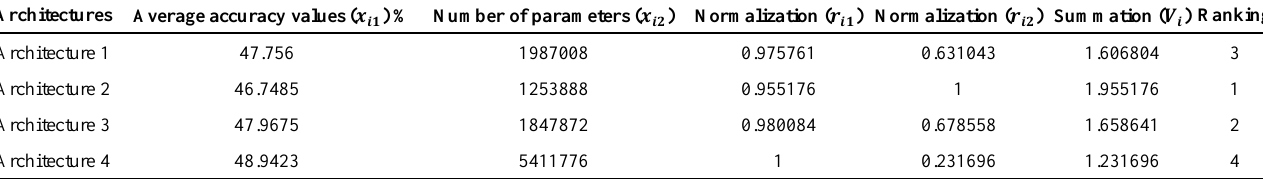
Table 3. Normalization results for the first stage of the DREAMER dataset